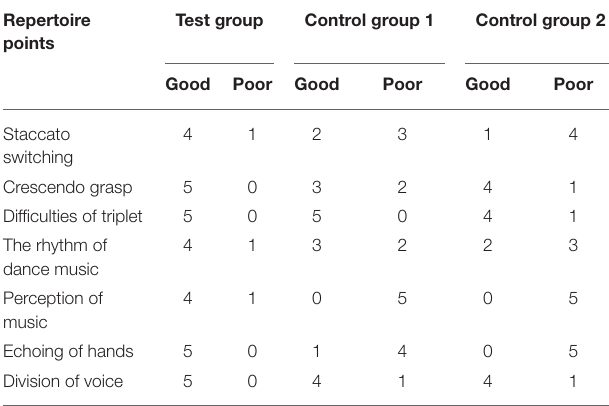
TABLE 7 | Comparison of piano teaching effects among groups in grade